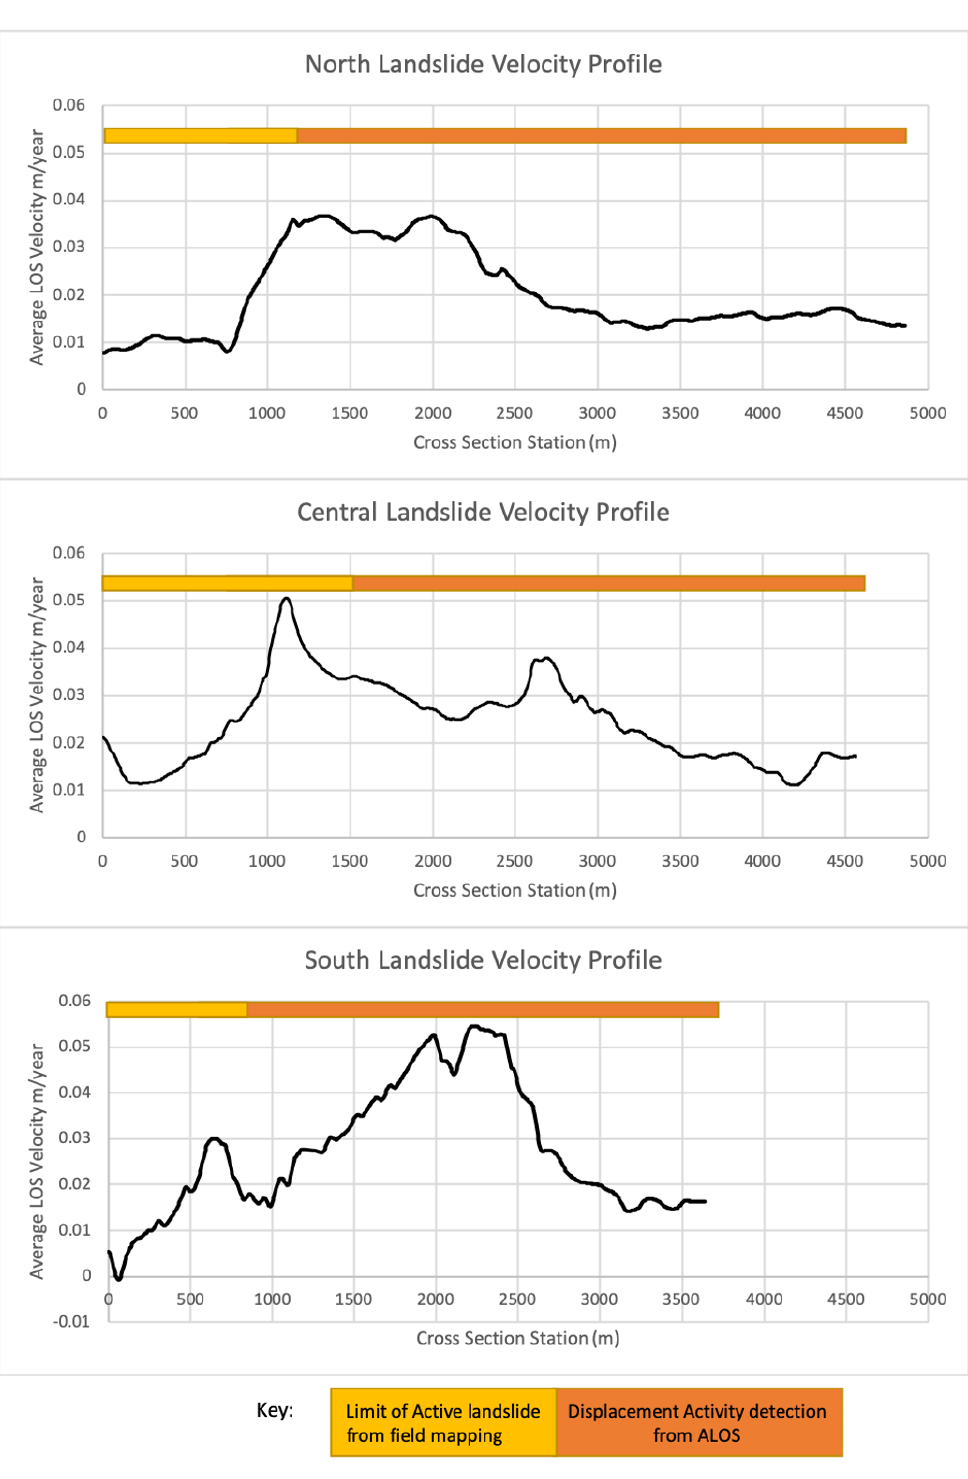
Figure 10. LOS velocity profiles of extended north, central, and south landslide extending beyond known boundaries of activity into the western hillslope of the Ragged